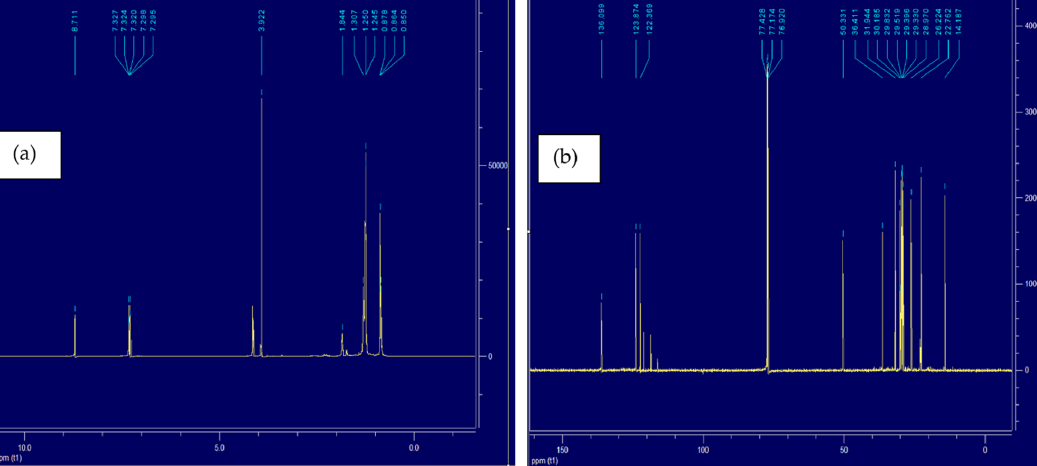
Figure 9. ( a ) 1 H NMR spectra of IL4-Oil, ( b ) 13 C NMR spectra of IL4-Oil. Table 5. NMR peaks shifts for 1H and 13C spectra for IL4 before and after the oil extraction. H Peaks Shifts C Peaks Shifts